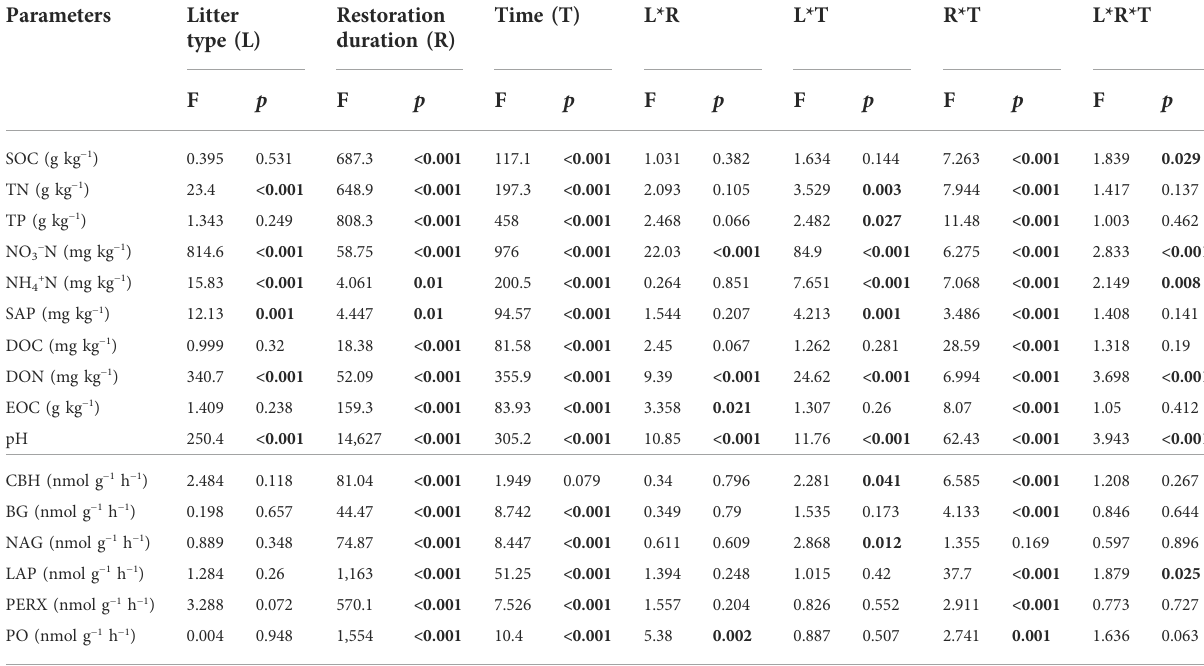
TABLE 3 Signi fi cance of the effects of litter type (L), restoration duration (R), decomposition time (T) and their interactions on soil properties and enzyme activities based on multiway ANOVA.